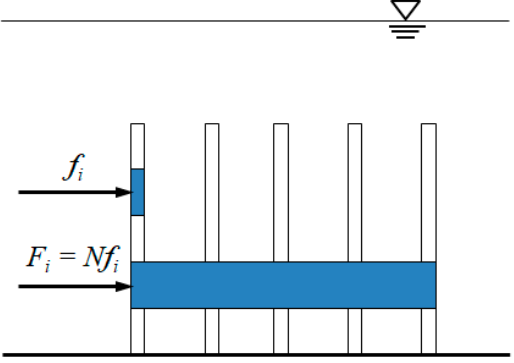
Figure 1. Resistance effect induced by